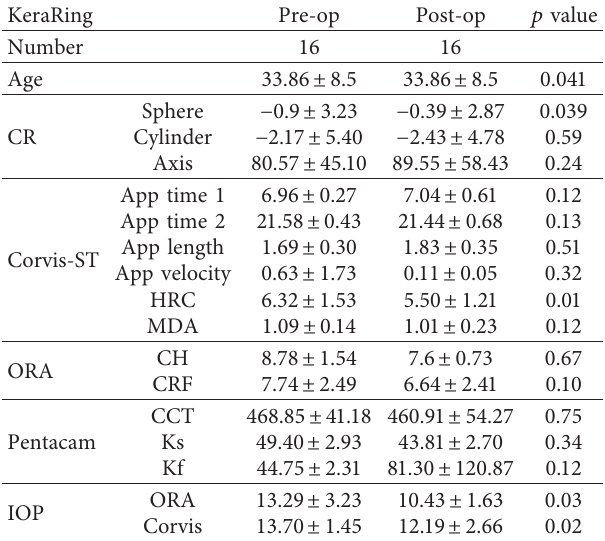
Table 3: The results of parameters of the group treated with KeraRing before and after ICRS